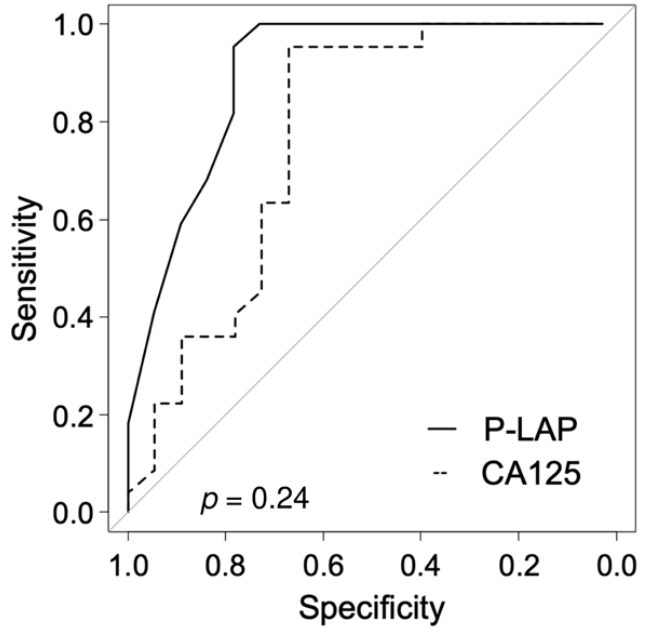
Figure 2. Receiver operating characteristics of urinary P-LAP and serum CA125.